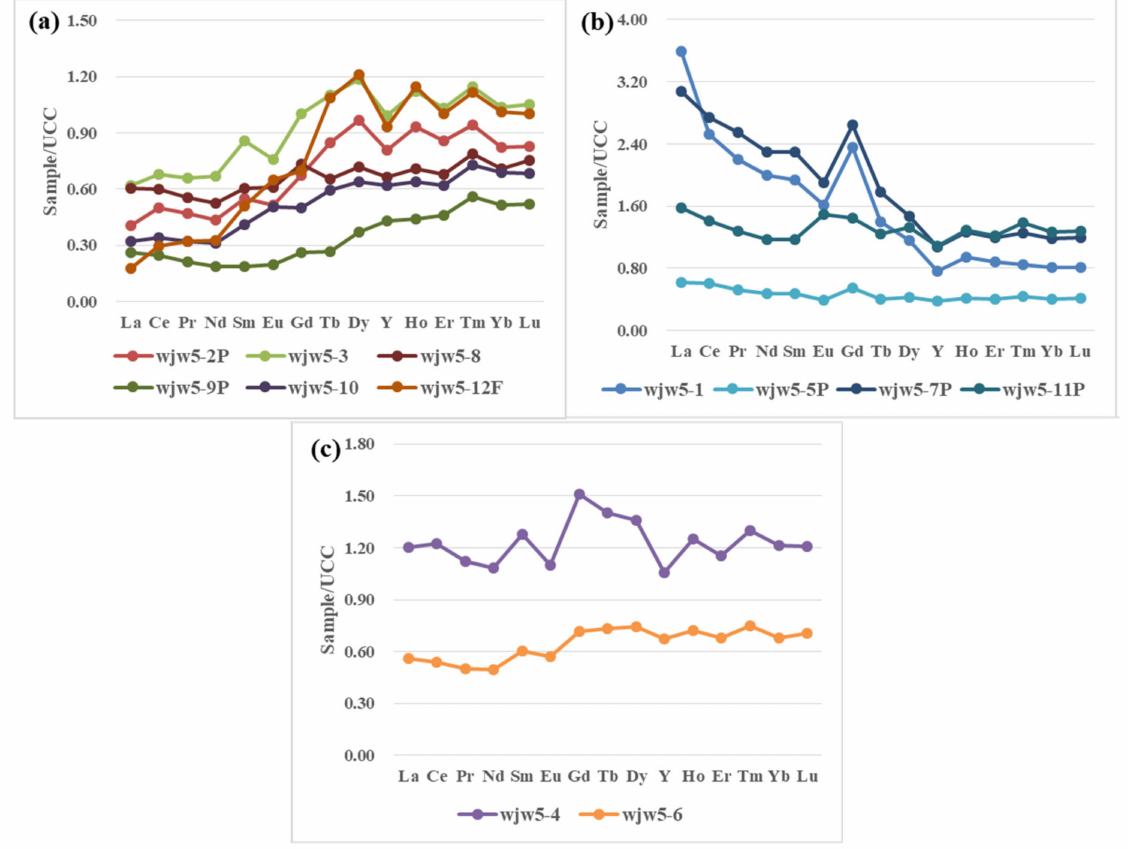
Figure 6. REY distribution patterns in the No. 5 coal (including coal and parting samples), normalized to the upper continental crust. ( a ) Patterns of H-type enrichment; ( b ), patterns of L-type enrichment; and ( c ), patterns of M-H-REY